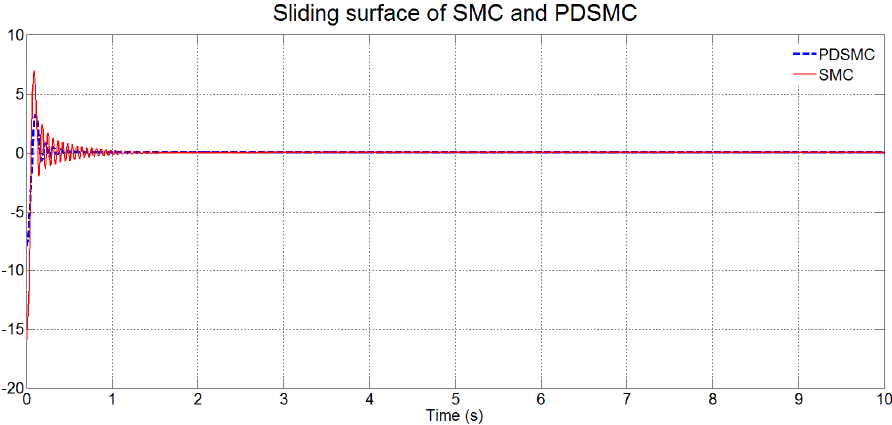
Figure 7. Sliding surface response of both schemes.